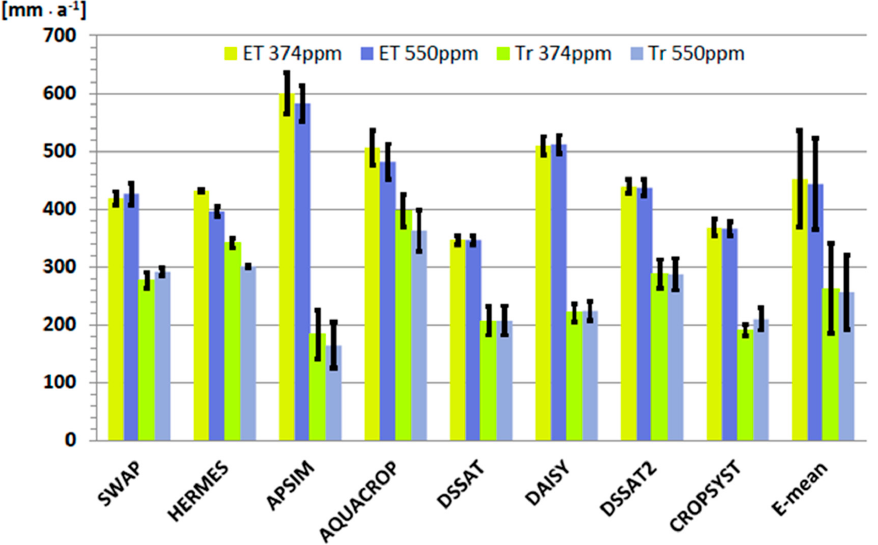
Figure 3. Simulated evapotranspiration (ET) and transpiration (Tr) for ambient (374 ppm) and elevated (550 ppm) atmospheric CO 2 concentration of the Braunschweig FACE experiment from different models. Error bars of the model results show inter ‐ annual variability, error bars of the ensemble mean the inter ‐ model variability.